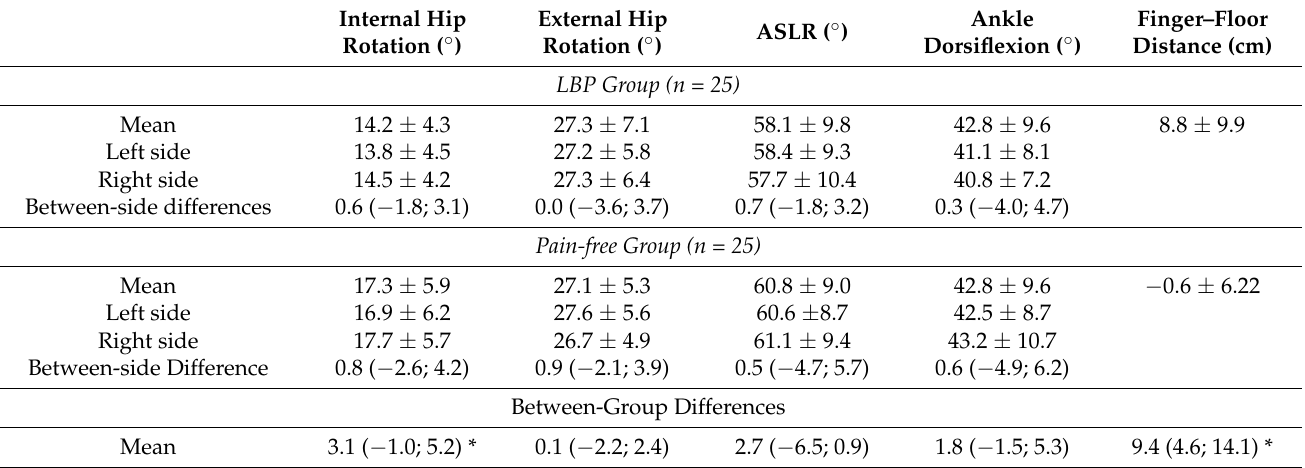
Table 2. Participants’ characteristics at